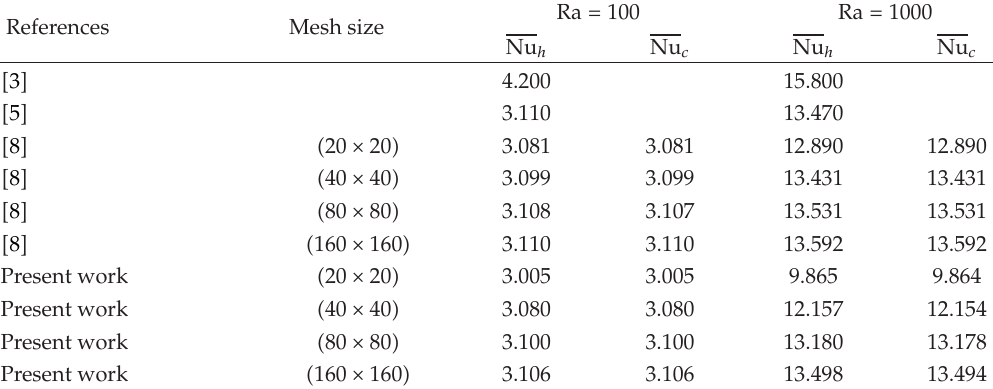
Table 1: Comparison of the average Nusselt number, Nu, against some previous results for isothermal vertical walls in a square cavity in the case φ (cid:8) 90 ◦